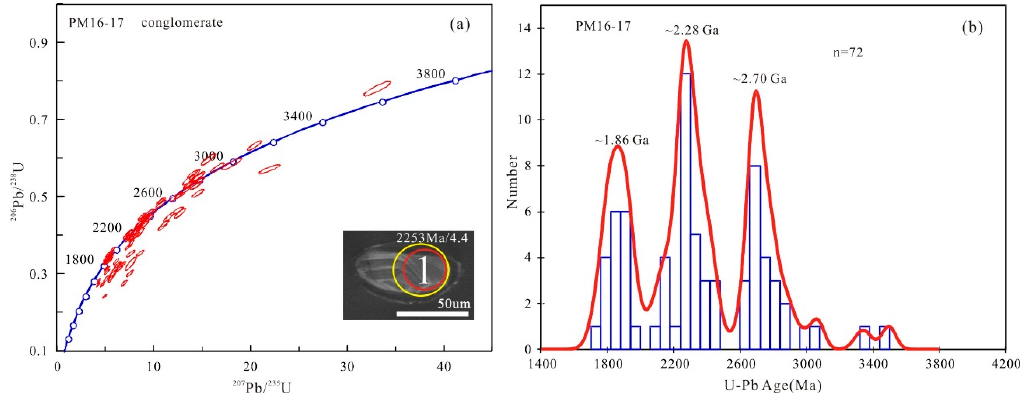
Figure 5. CL images and concordia plots ( a ) and statistical distribution ( b ) of zircon U–Pb dating for conglomerate (PM16-17) of DCG. Red and yellow circles indicate the locations of U–Pb dating and Hf